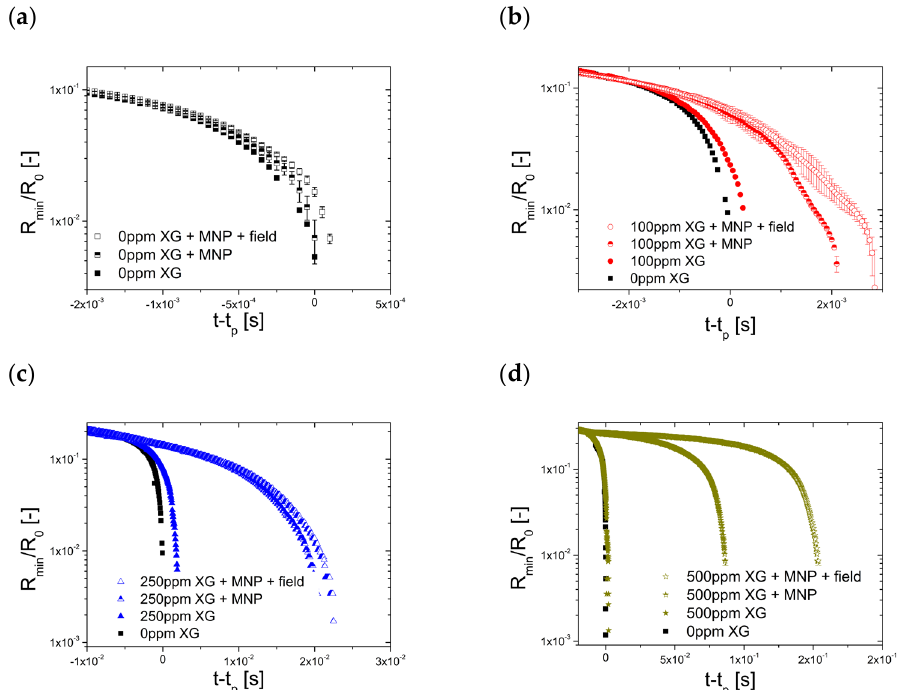
Figure 5. Effect of the addition of DB magnetic particles (MNP) and subsequent application of a magnetic field on the breakup time of formulations XG0 ( a ), XG100 ( b ), XG250 ( c ) and XG500 ( d ).